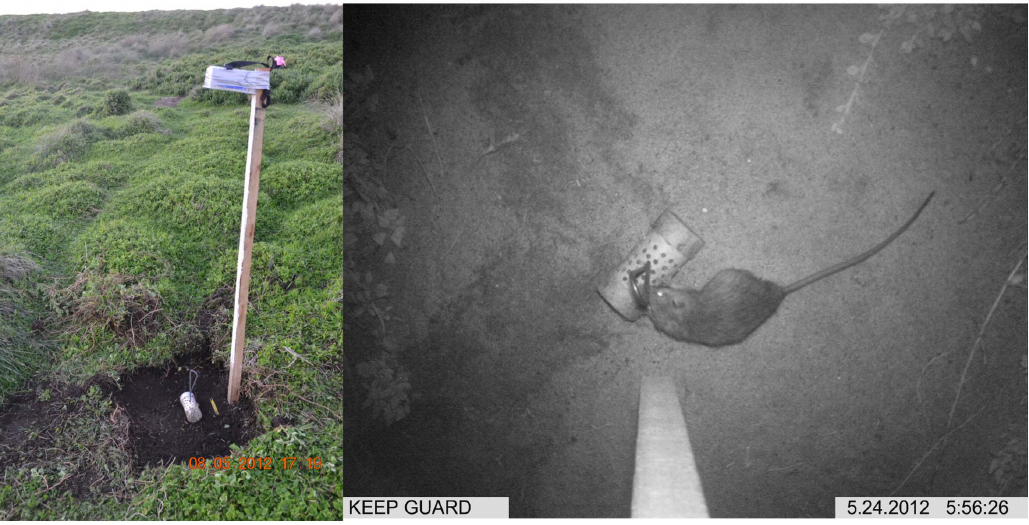
Figure 1. The set-up of the camera traps used in this research. Horizontal mounting setup demonstrating how the camera provides a ‘birds- eye view’ of the bait lure (left). Image of a black rat (right) demonstrating the type of images obtained, and the ease of identifying key features (tail length, ear morphology).